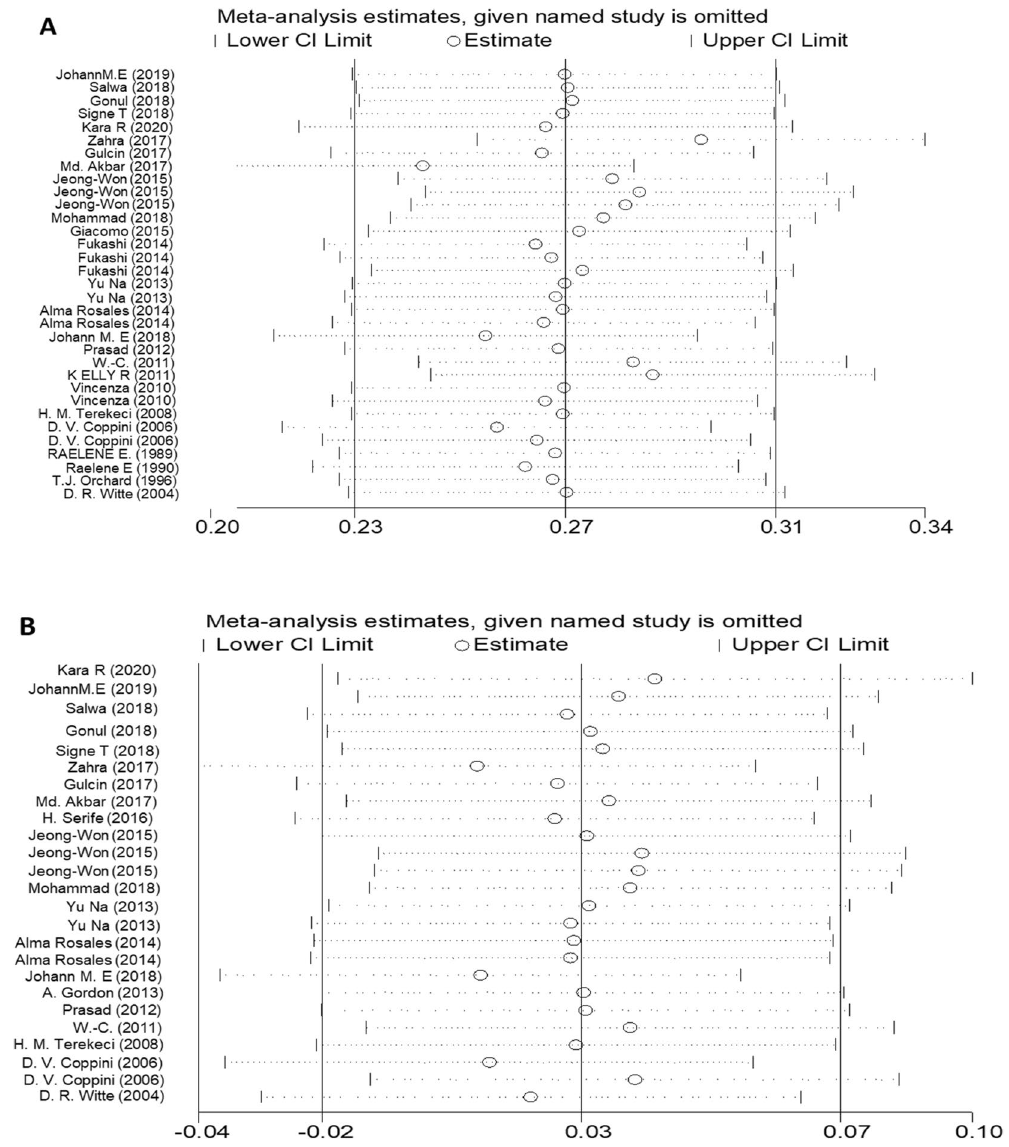
Figure 8. Sensitivity analysis of the pooled MD for ( A ) TG, ( B ) TC, ( C ) HDL, and ( D )